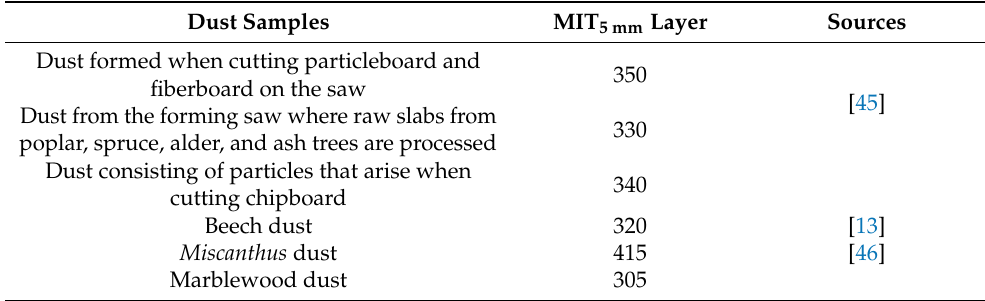
Table 3. Results from the testing of the minimum ignition temperature of a 5 mm dust layer.